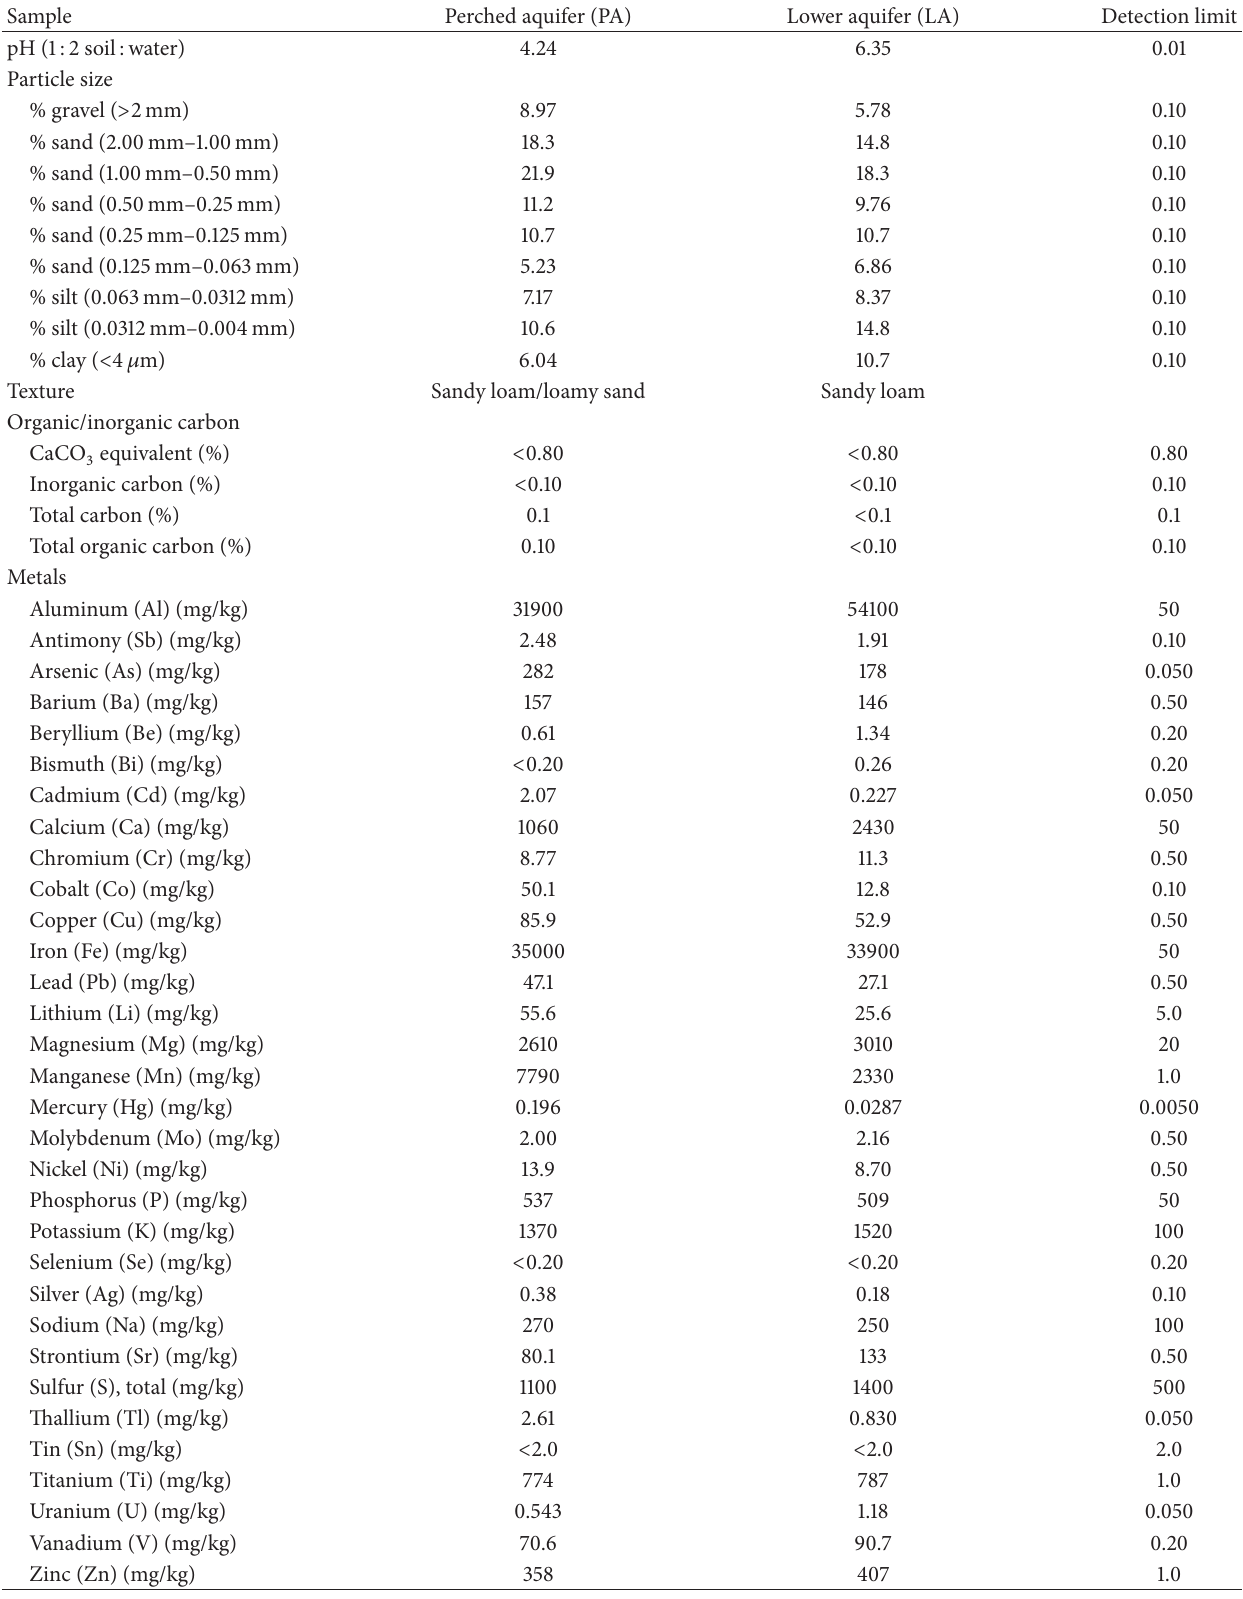
Table 1: Characteristics of aquifer